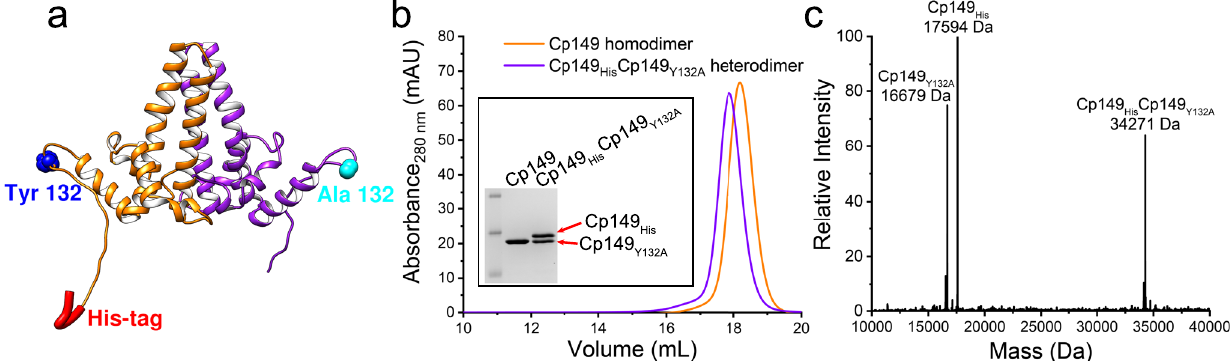
Fig. 2 Design and puri fi cation of the engineered heterodimer, Cp149 His Cp149 Y132A . a A model of the modi fi ed heterodimer based on 1QGT. The contact helix and subsequent loops, with residue 132, extend to the right and left of the base of the dimer. A six-histidine His-Tag is attached to the C terminus of one monomer (orange) and an assembly-incompetent mutation (Y132A) is present on the other monomer (purple). b Puri fi ed heterodimer, Cp149 His Cp149 Y132A , shows a single peak by SEC (purple) and elutes similarly to puri fi ed Cp149 homodimers (orange). SDS-PAGE shows a single band for Cp149 homodimers, whereas Cp149 His Cp149 Y132A shows two equally dense bands corresponding to the two different monomers (inset). c Native mass spectrometry of Cp149 His Cp149 Y132A shows three species corresponding to the different monomers and the disul fi de crosslinked heterodimer. No MS evidence was found for the Cp149 His homodimer or Cp149